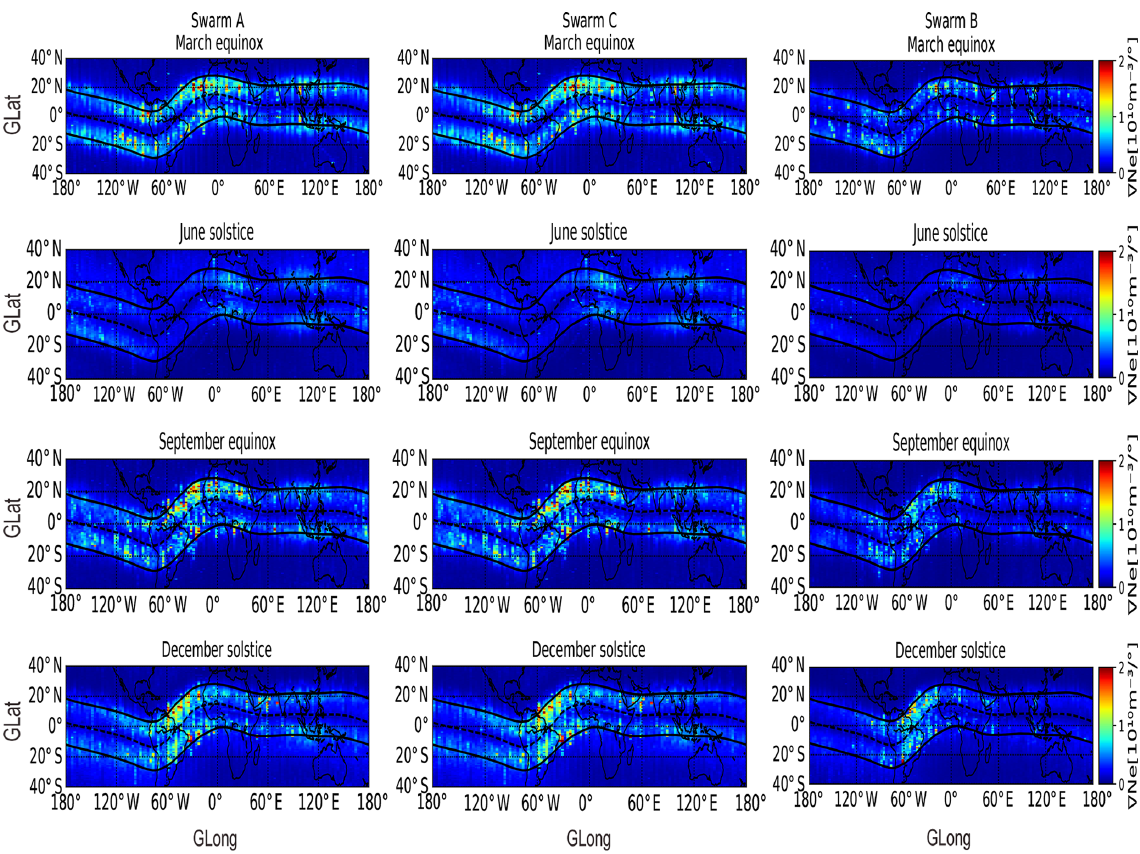
Figure 9. Along-track electron density gradient ∇ N e as derived from the Swarm satellites separated into four seasons (March or September equinox and June or December solstice) from October 2014 to October 2018 for Swarm A, C and B. The black dotted line represents the magnetic equator, while the black solid lines represent the EIA belts at about ± 15 ◦ of magnetic latitude.